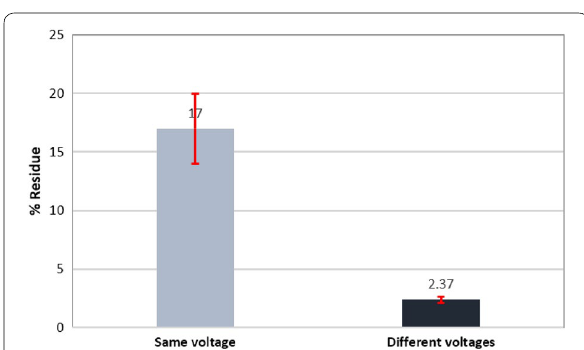
Fig. 6 Percent residue comparison for cases of same applied voltage and the different applied voltages. Error bars represent standard